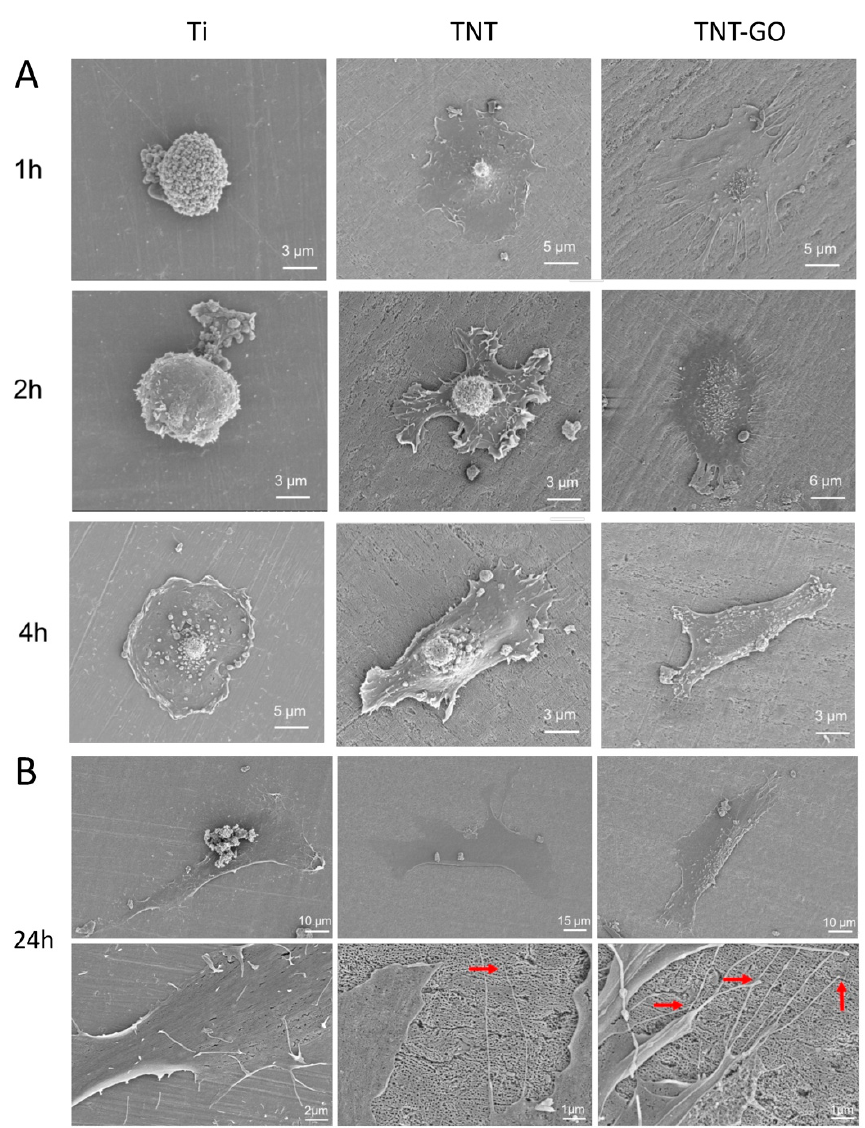
Figure 4. Scanning electron microscopy (SEM) images of HGFs on the different surfaces. ( A ) 1, 2, and 4 h. ( B ) 24 h. Red arrows indicate filopodia anchorage within